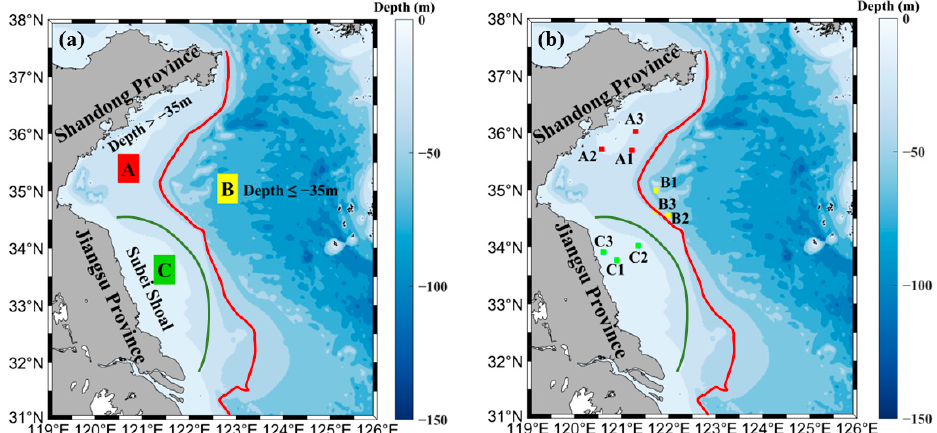
Figure 1. Study area and Location diagram of extraction regions in different environments for accuracy assessment (( a ) Partition diagram, where the red line is the − 35 m isobath and the area within the green line represents Zone C, which is the muddy water area. ( b ) Accuracy assessment areas A1–A3, B1–B3, and C1–C3 corresponding to the three partitions of A, B, and C).